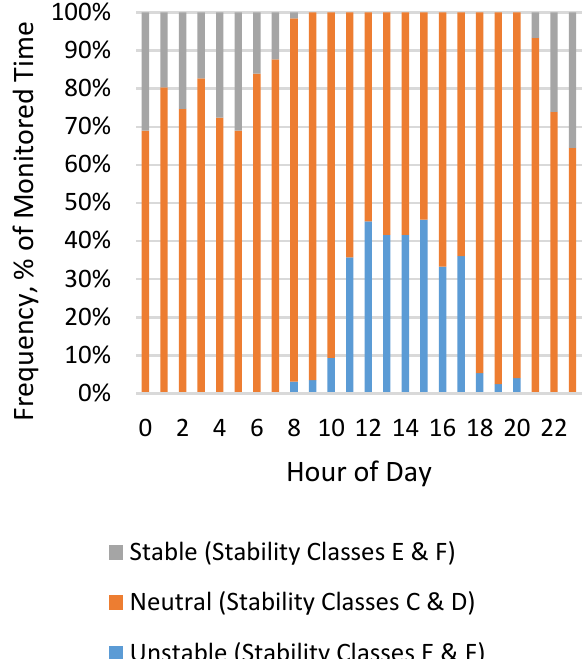
Figure 7. Frequency (% of monitoring period when the wind was in the direction of the downwind sensors—28.5% of the total monitored period) of wind measurements at the swine site, classified by hour of day and Pasquill – Gifford stability classes.